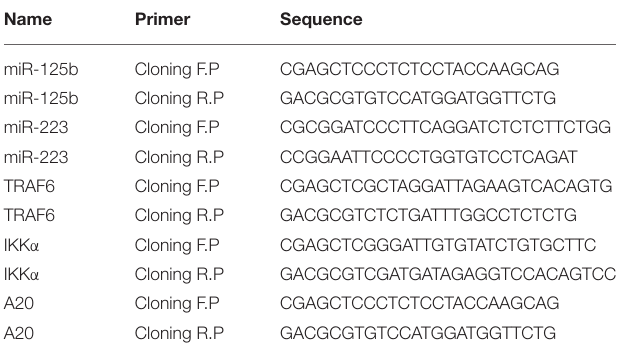
TABLE 3 | Primers used for cloning of miRNAs and their respective gene